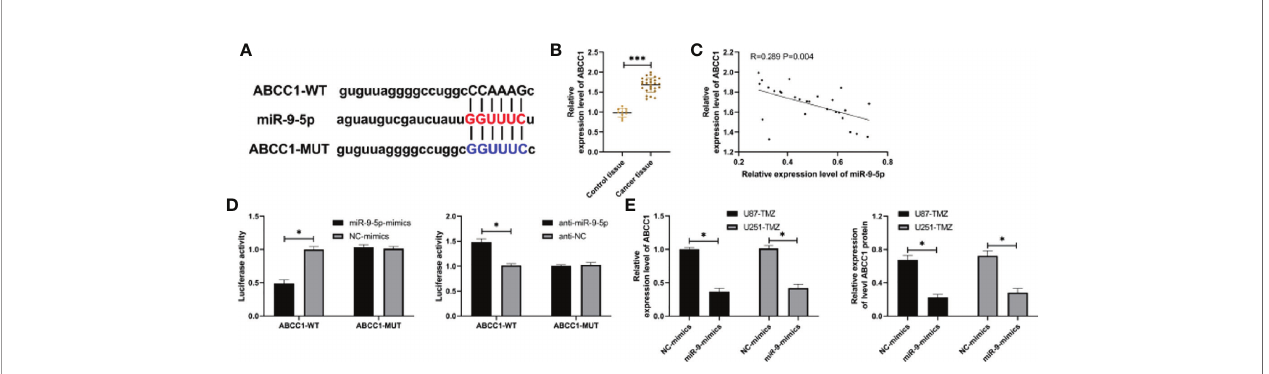
FIGURE 3 | miR-9-5p has a targeted regulation relationship with ABCC1. (A) miR-9-5p and ABCC1 target binding site. (B) qRT-PCR was used to detect the relative expression of ABCC1 in tumor tissues of patients with glioma. (C) Correlation analysis showed that miR-9-5p was negatively correlated with ABCC1. (D) Double luciferase report analysis of miR-9-5p and ABCC1 targeted binding. (E) qRT-PCR and WB test were used to detect the relative expression of ABCC1 in U87-TMZ/U251-TMZ cells after up-regulating miR-9-5p. *indicates P < 0.05; *** indicates P < 0.001.